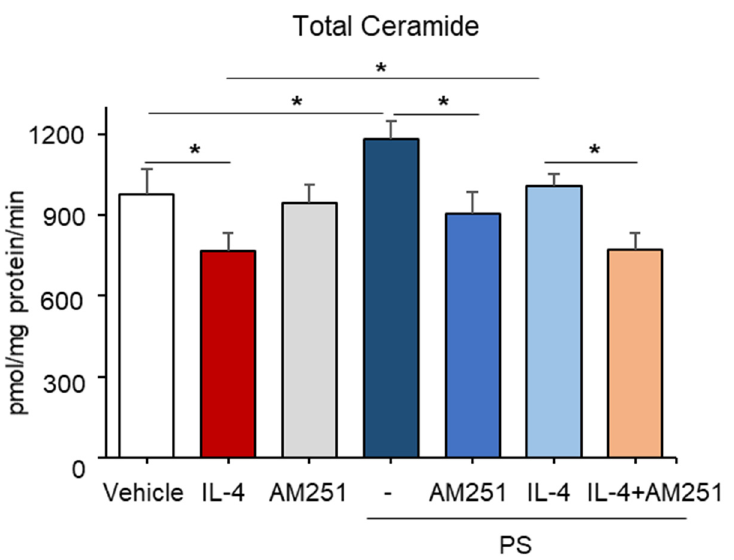
Figure 5. Involvement of the endocannabinoid receptor CB1 in the N-palmitoyl serinol (PS)-mediated stimulation of overall ceramide content. HaCaT KC were pretreated with IL-4 (50 ng/mL) for 20 h, followed by incubation with exogenous PS (25 µ M) with or without CB1 inhibitor (AM-251, 10 µ M) for 4 h. Total ceramide content was assessed by the LC-MS/MS system. Statistical significance was calculated using the unpaired Student’s t -test, and significance was defined as * p < 0.01 vs. vehicle control (or untreated control).